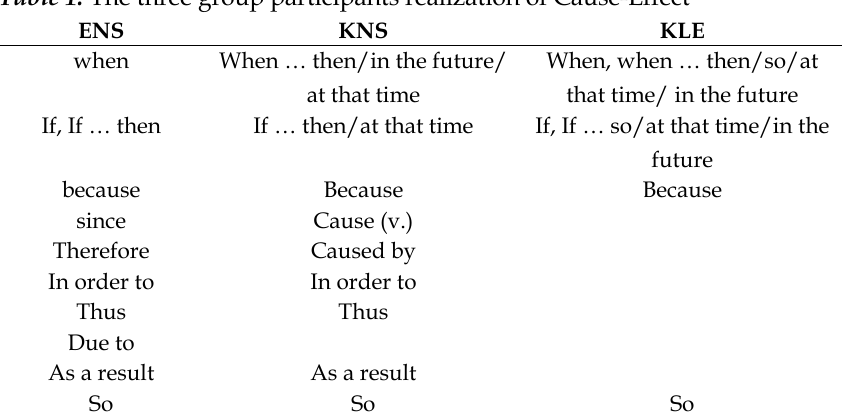
Table 1. The three group participants realization of